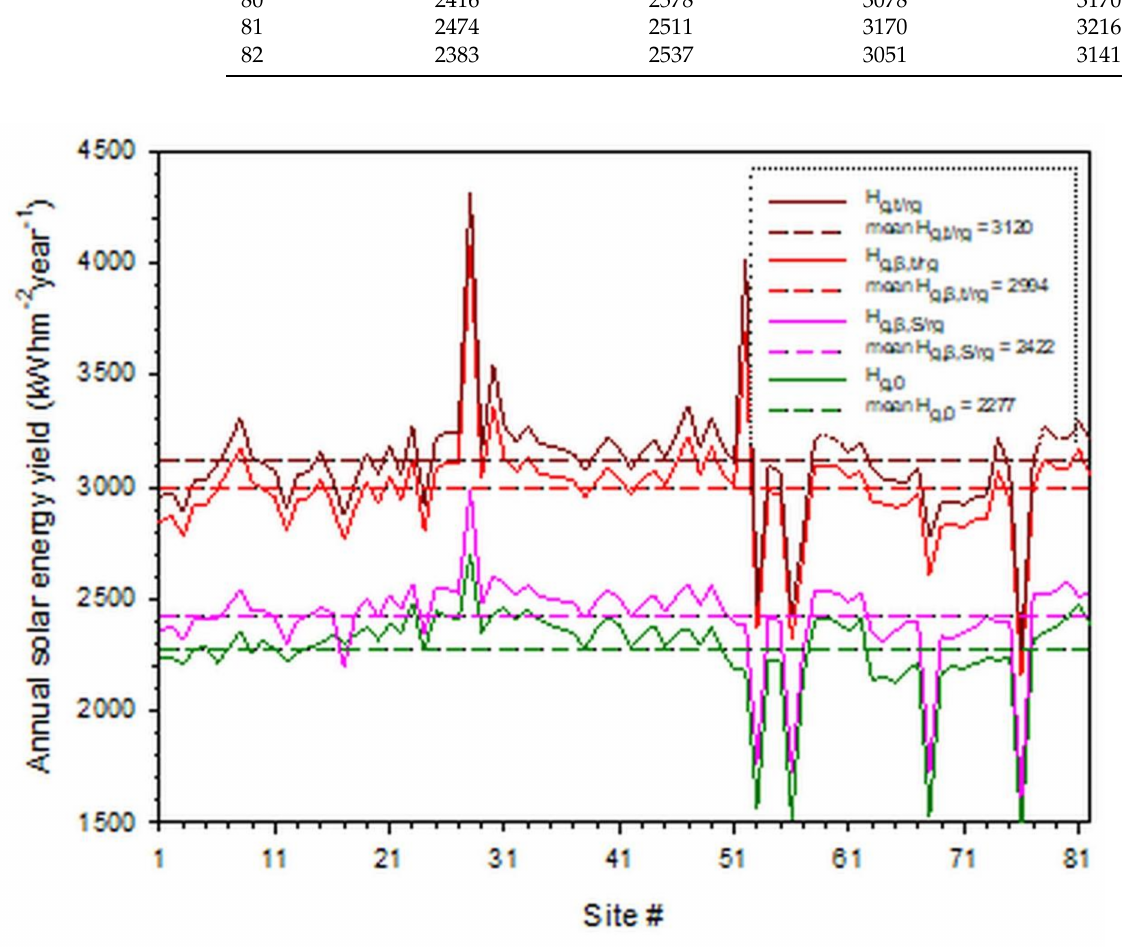
Figure 3. Variation of the maximum annual solar energy yield across the 82 selected sites in Saudi Arabia on horizontal surface (green lines), on inclined flat-plate surfaces of mode (i) static (purple lines), of mode (ii) dynamic (red lines), and of mode (iii) dynamic (brown lines) systems. The solid lines represent the variation of the annual yield across all sites, while the dashed ones represent the means of the